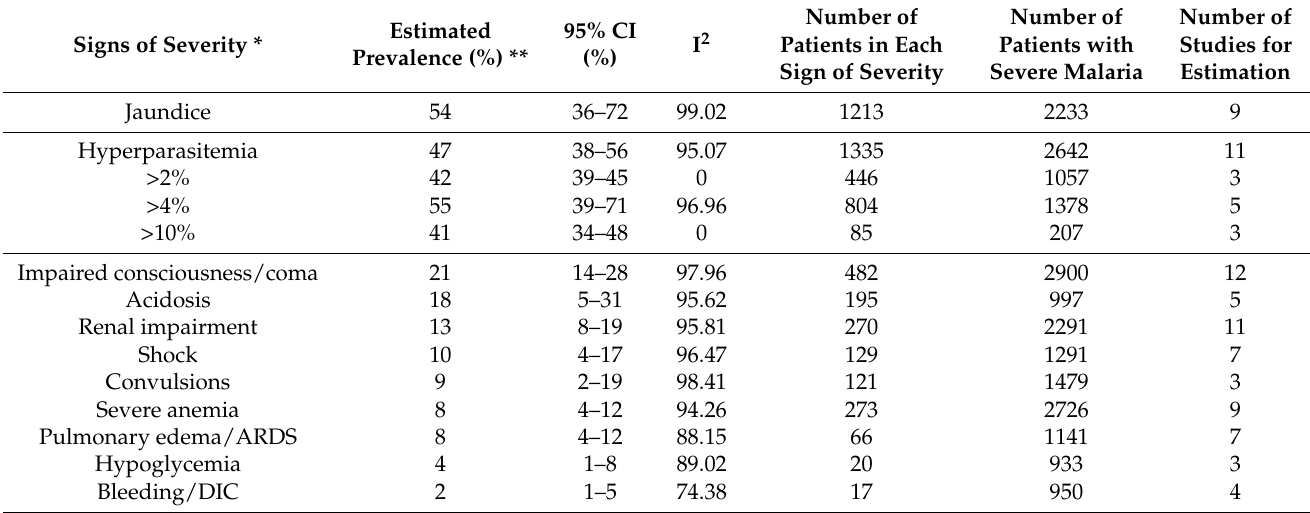
* Signs of severity by guidelines for the treatment of malaria 2015, and WHO Guidelines for malaria 2021, except for hyperparasitemia >2% and >4% adapted guidelines. ** The pooled prevalence was estimated by the random-effects